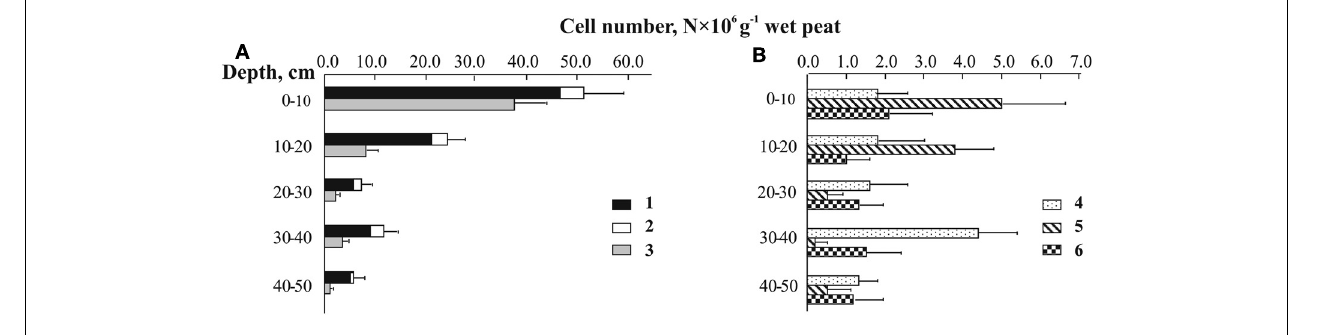
2 – OP3-related group, 3 – Isosphaera – Singulisphaera group, (B) 4 – Zavarzinella -like planctomycetes, 5 – Schlesneria